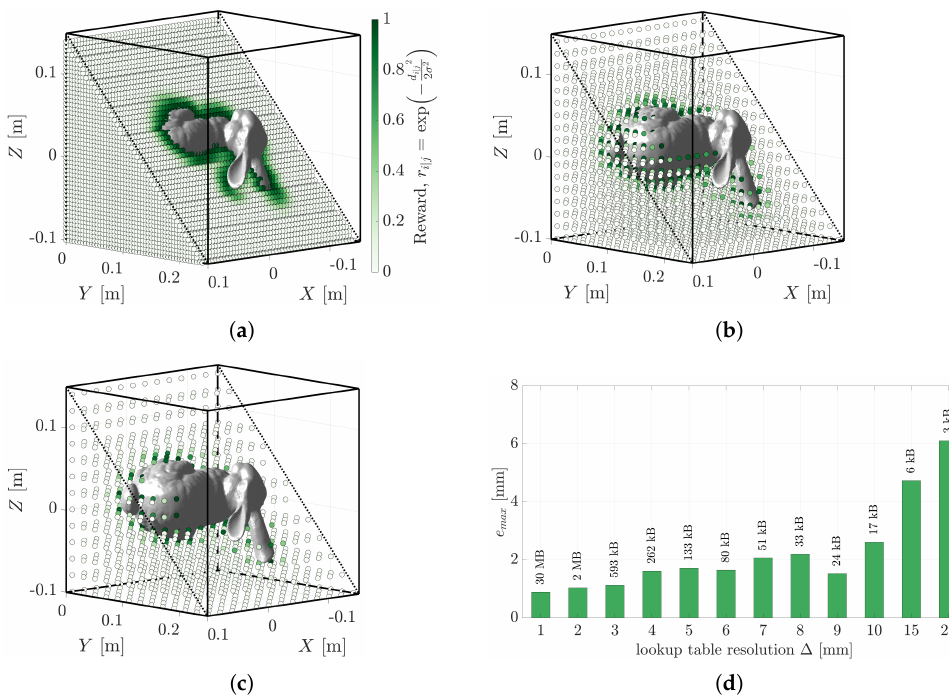
Figure 13. Visual representation of the lookup table for the Stanford Bunny at various lookup table resolutions: ( a ) 5 mm, ( b ) 15 mm, and ( c ) 20 mm. ( d ) Displays the minimal effect on the maximum